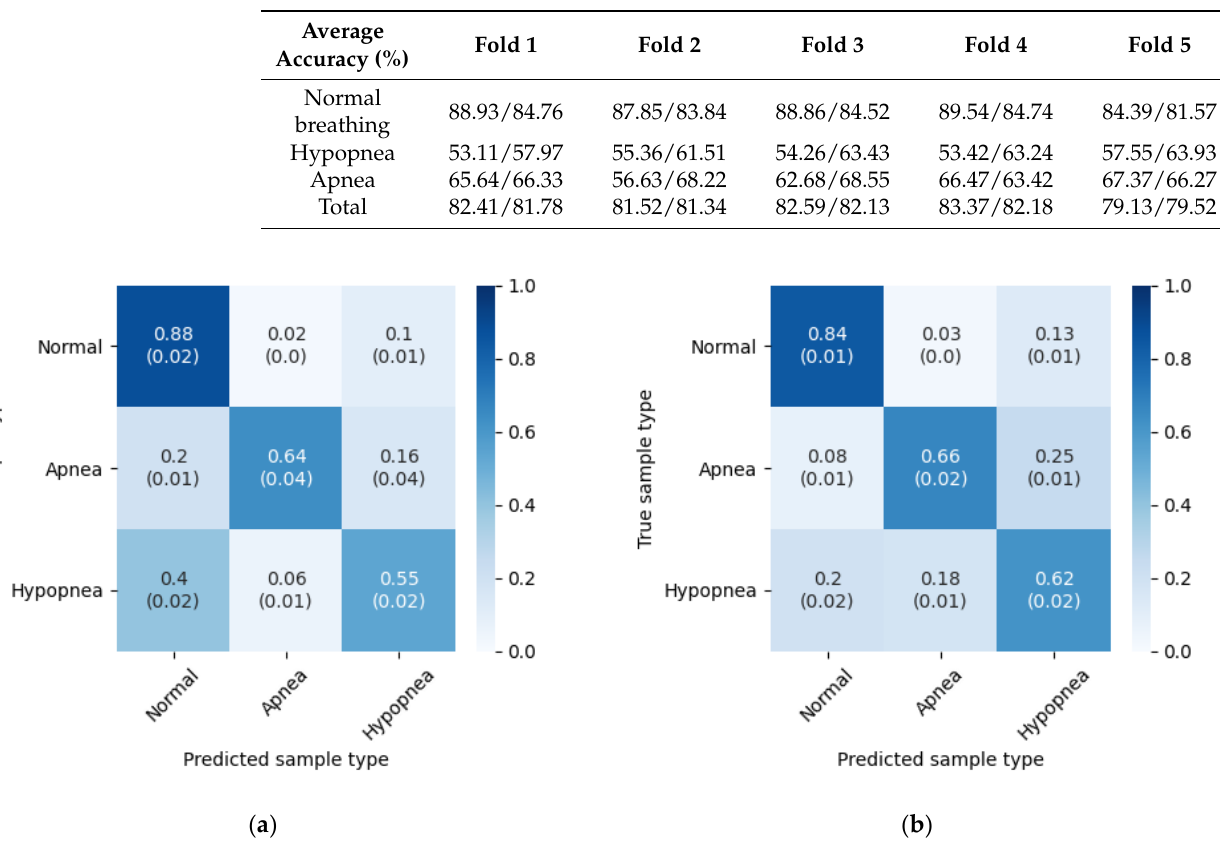
Table 7. Three- class inference performance of each instance of the model with “Wake” periods removed. Values for SHHS- Table 7. Three-class inference performance of each instance of the model with “Wake” periods 1/Physionet datasets. removed. Values for SHHS-1/Physionet datasets.